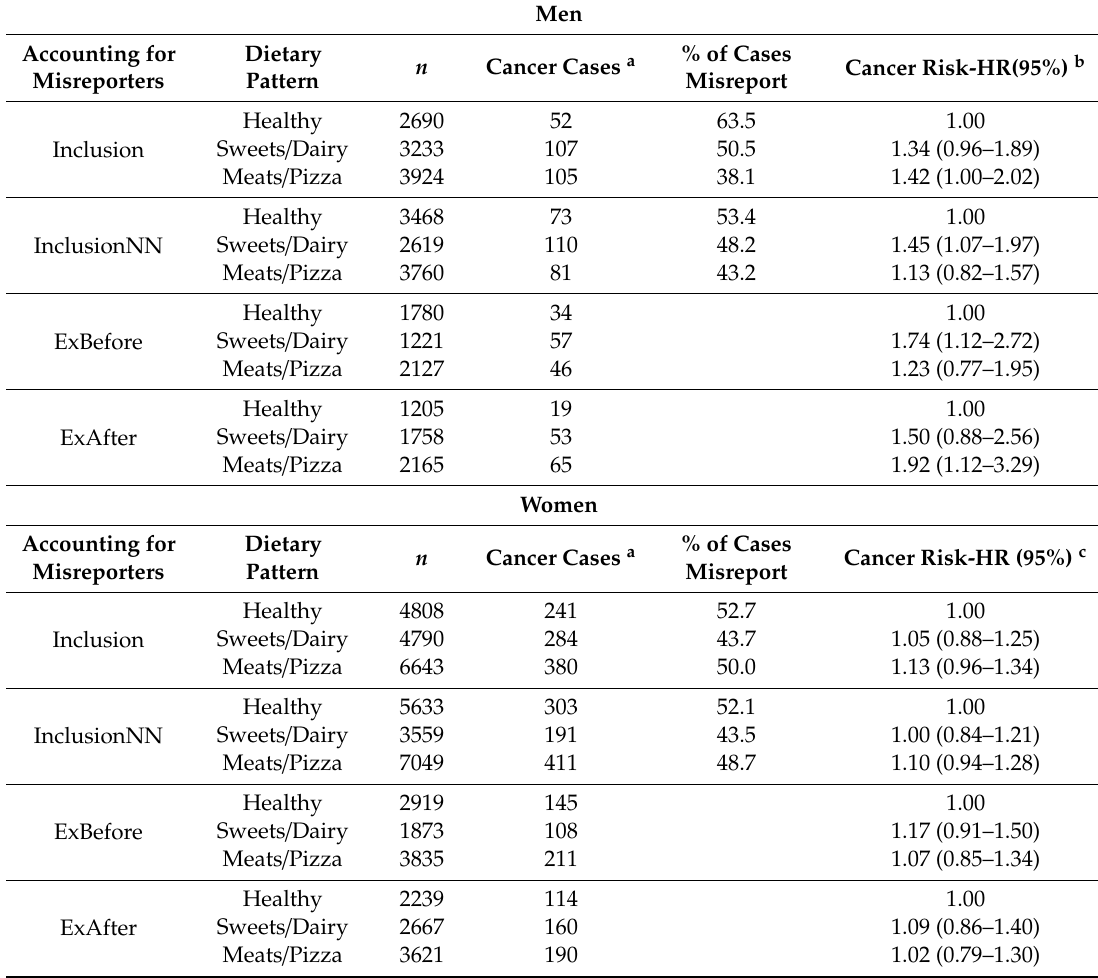
Table 5. Multivariable Cox proportional hazards ratio of the incidence of Dietary-Cancers a stratified by four methods to account for